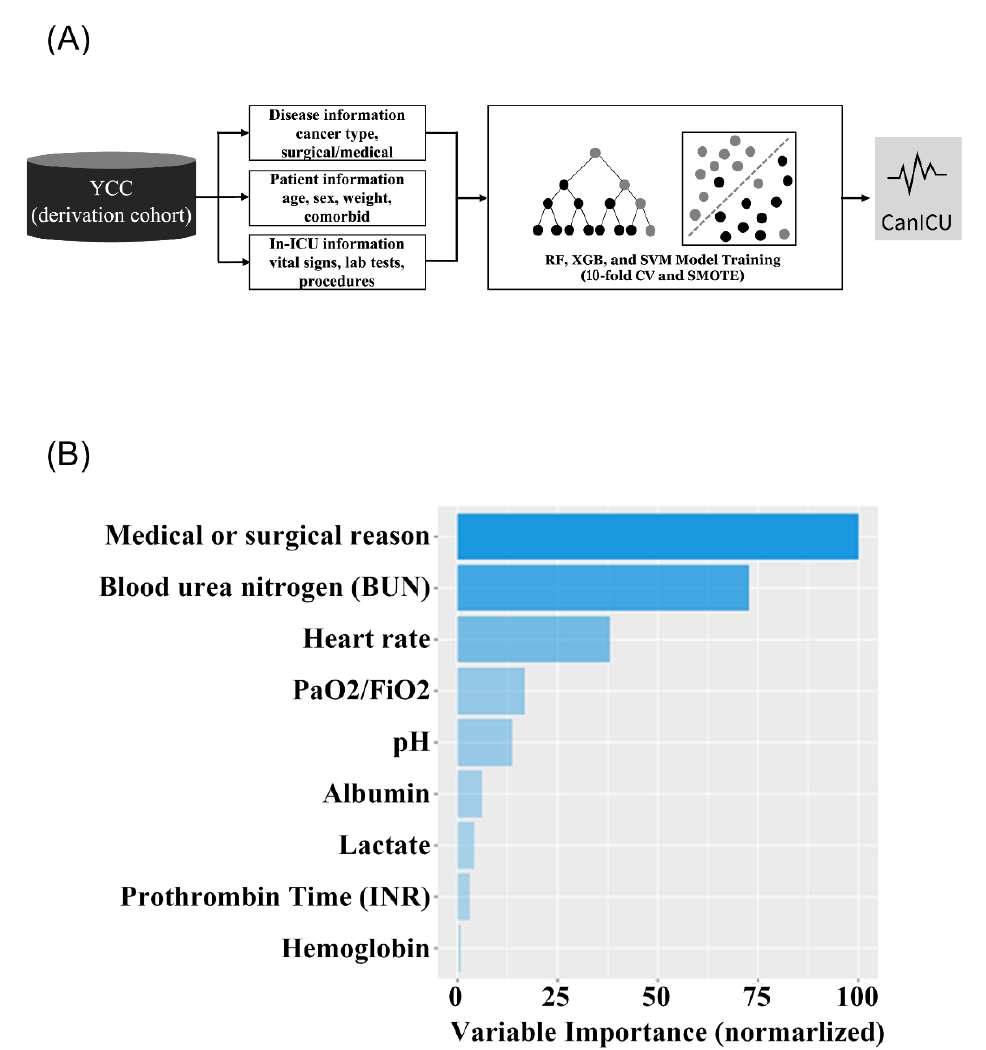
Figure 1. Architectural overview and feature importance of CanICU: ( A ) Architectural overview of CanICU. ( B ) Feature importance for predicting 28-day mortality. YCC, Yonsei Cancer Center; RF, random forest; XGB, xgboost; SVM, support vector machine; CV, cross validation; SMOTE, synthetic minority oversampling technique. Evaluation of short term 28-Day mortality prediction in CanICU.